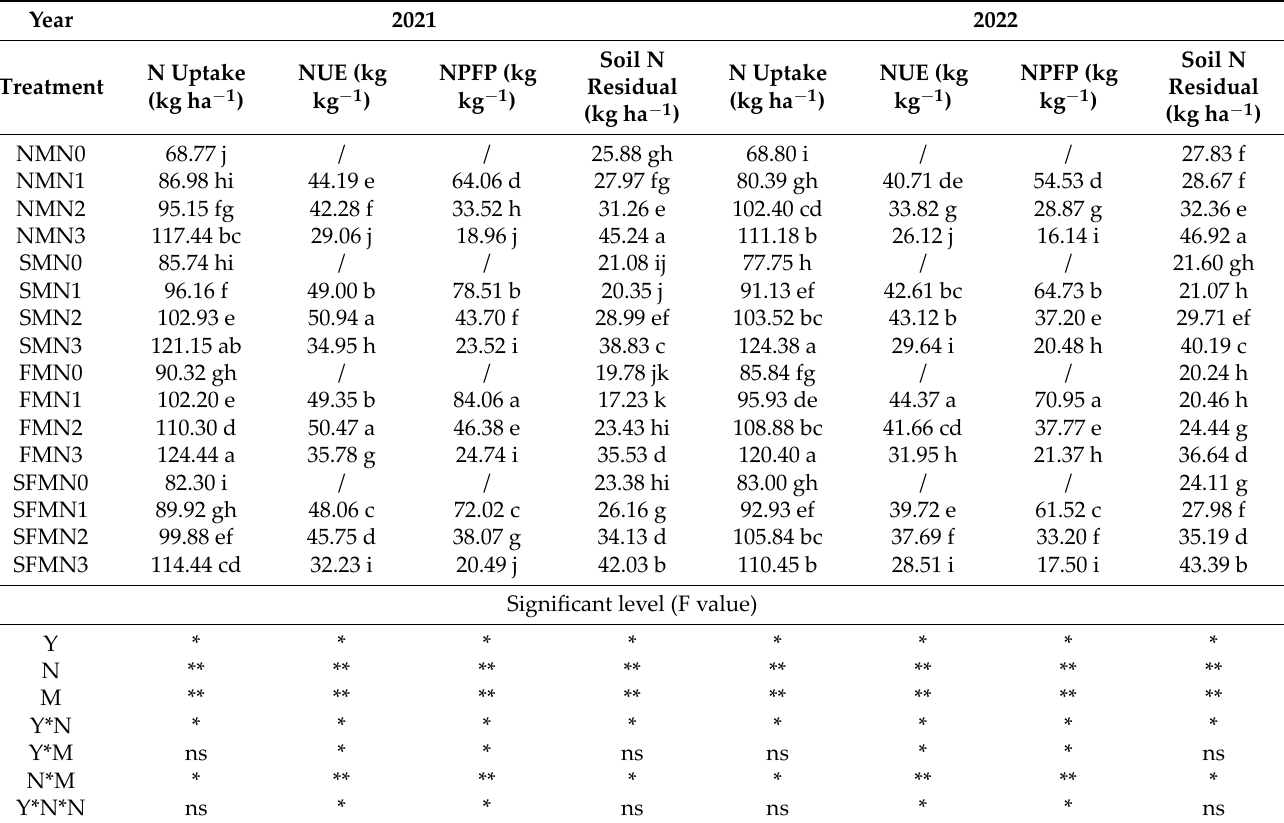
Table 4. Effects of different mulching methods and different nitrogen application on nitrogen